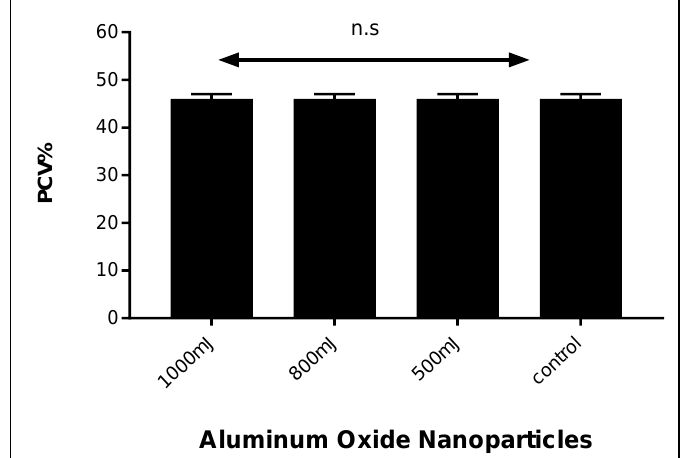
Figure 6: PCV level in blood samples in the presence and absence of Al 2 O 3 NPS at different energy (500, 800, and 1000) mJ.